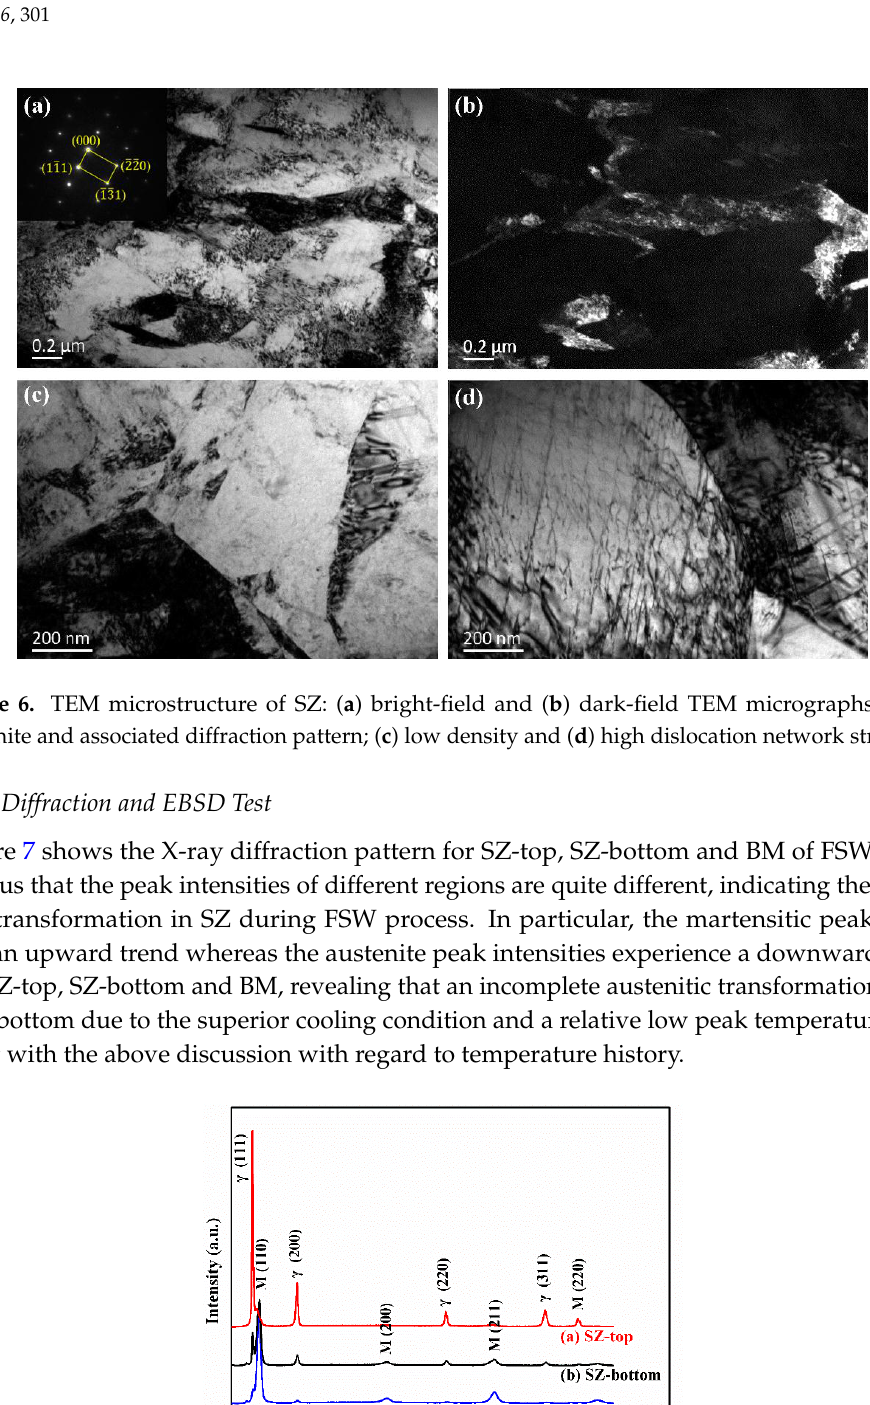
Figure 7. XRD profiles of welded sample: ( a ) SZ-top, ( b ) SZ-bottom, and ( c ) BM.